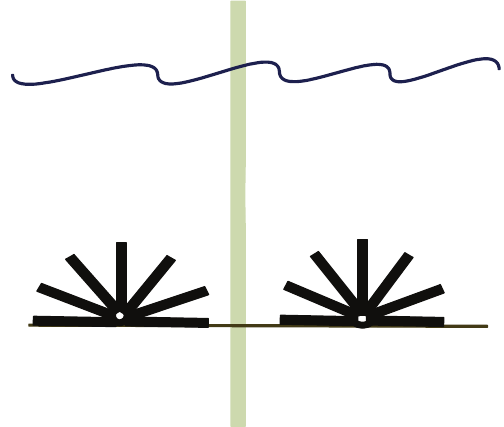
Figure 3: An illustration of the design of the reef system scouring protection around a monopile wind